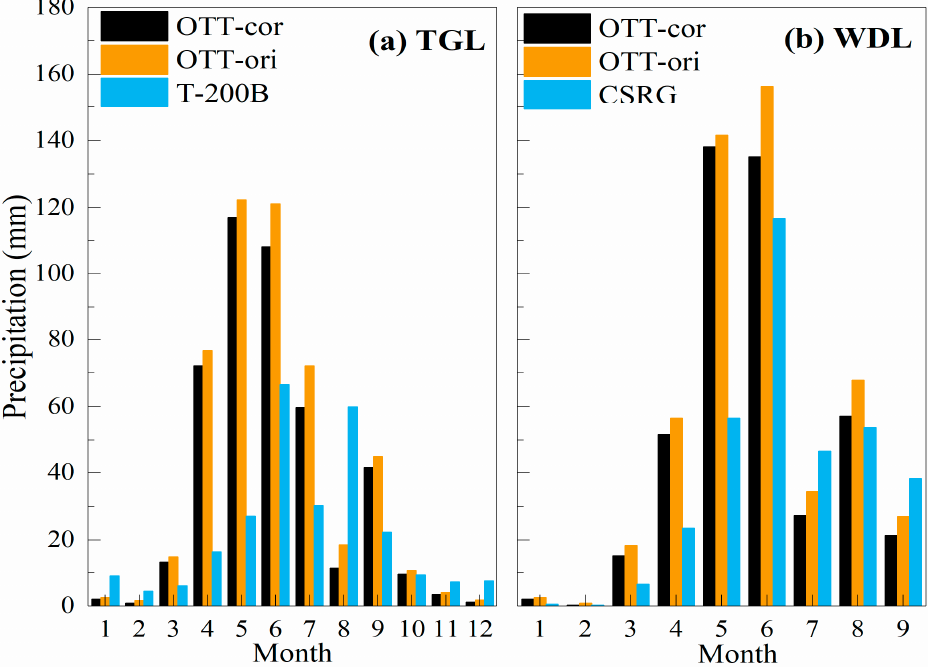
Figure 5. Comparison of observational results obtained by the OTT Parsivel 2 instrument and other rain gauges at ( a ) Tanggula and ( b ) Wudaoliang. OTT-ori refers to the origin output recorded by the Parsivel 2 instrument; OTT-cor refers to quality control of the data by the de-extreme method; T200B refers to the results observed by the Geonor T-200B rain gauges; and Chinese standard rain gauge (CSRG) refers to the results observed by Chinese standard rain gauges.